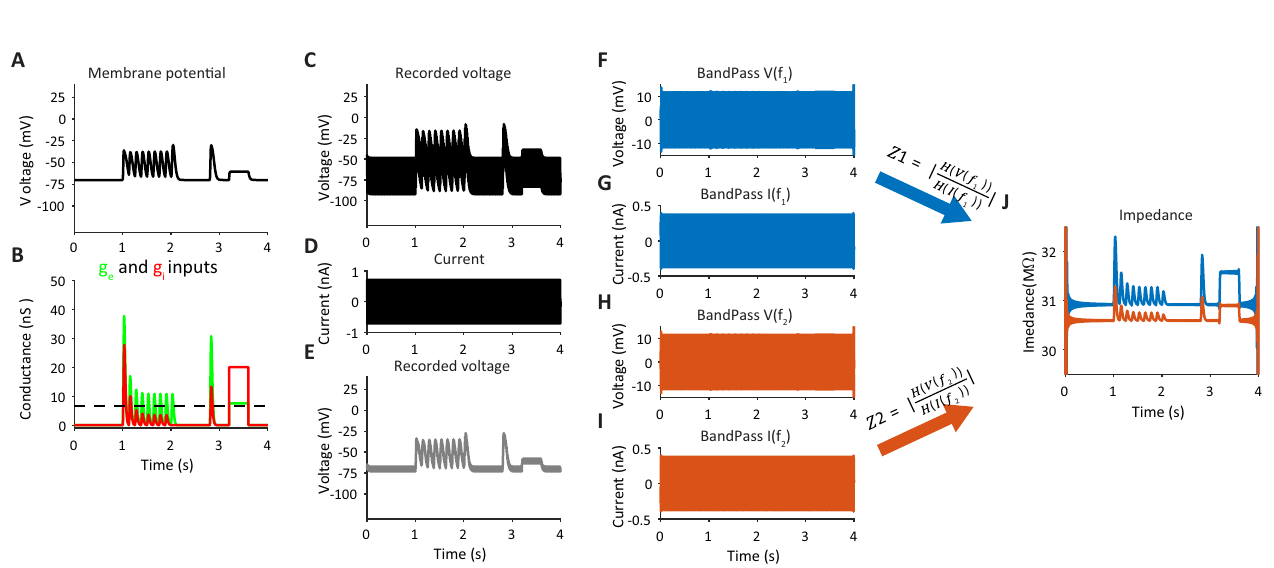
Fig 3. Measurement of total impedance in a single trial -simulation of a point neuron. A. Simulated membrane potential of a point neuron when receiving synaptic conductances as shown in B. (excitation–green, inhibition–red). C-D. The voltage response of a simulated neuron I receiving synaptic inputs described in b and injected with a current composed of two sinusoidal components (d, 0.375nA, 210Hz and 315Hz). ‘Recording’ was made via an electrode of 30M Ω and thus most of the voltage drop due to the injected current occurred across the electrode. E. The actual voltage change across the membrane was small (as ‘recorded’ when electrode resistance was set to zero). F-I. voltage and current traces when filtered at the two frequencies used to compose the current. Note for the small fluctuations in voltage. J Impedance curves for each of the two frequencies obtained by dividing the Hilbert transform of the voltage and current shown in F-I and then taking the absolute values. Edge effect of the filtering is observed near zero and end times of the traces.